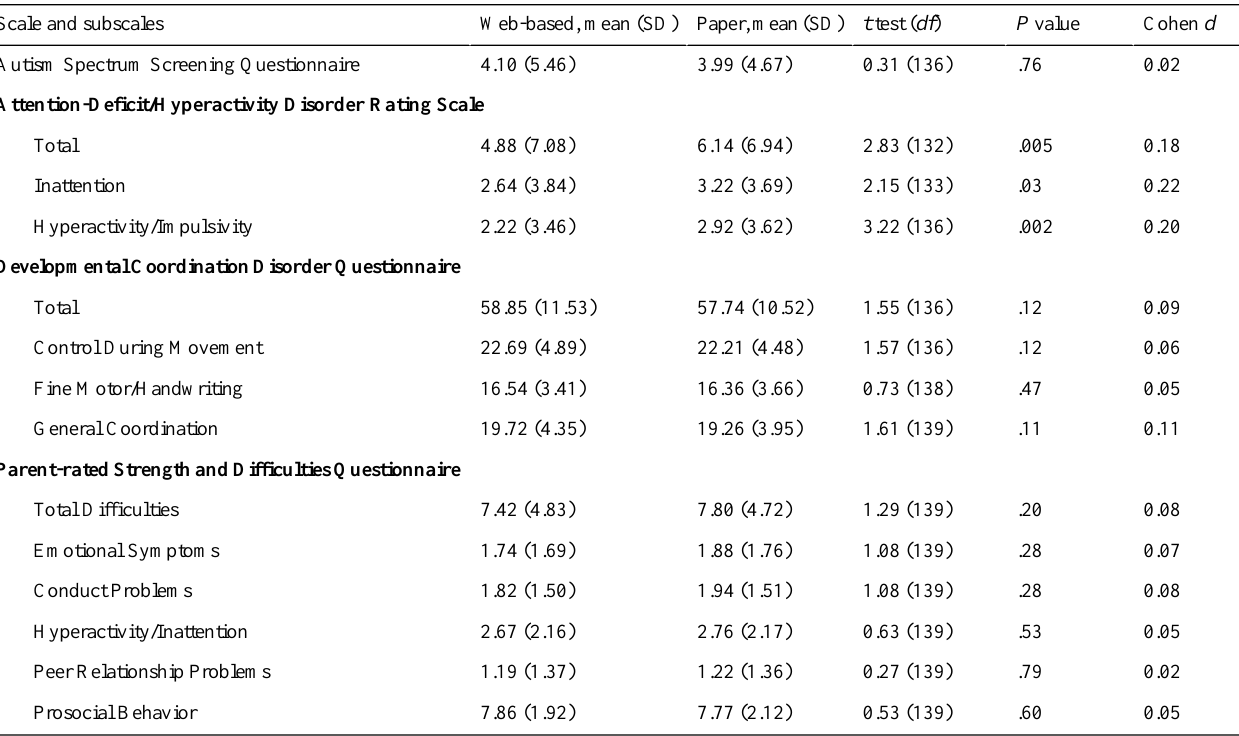
Table 4. Mean scores for the web-based and paper formats of ASSQ, ADHD-RS, DCDQ, and P-SDQ